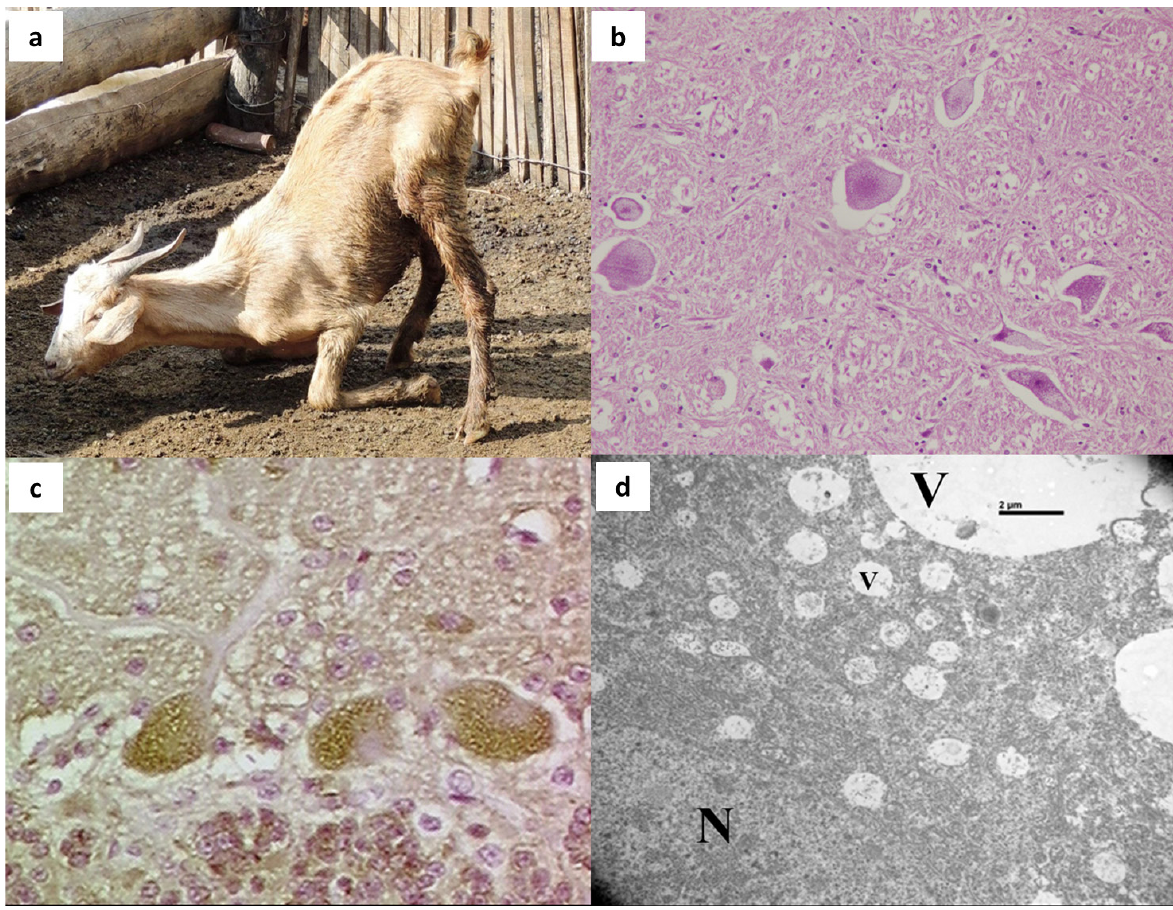
Figure 4. a. Clinical signs. Spontaneous poisoning of a goat by Sida rodrigoi . The goat shows abnormal posture due to difficulty in standing. b. Histology. Spontaneous poisoning of sheep by Astragalus garbancillo . Cerebellar basal nuclei show severe cytoplasmic vacuolation. HE, bar 25 μm. c. Lectin histochemistry. Spontaneous poisoning of a goat by Sida rodrigoi . Lectin WGA labeled the perikaryon of Purkinje cells in goats. Lectin histochemistry, bar 25 μm. d. Transmission electron microscopy (TEM). Experimental poisoning of sheep by Astragalus pehuenches . Purkinje cell showing numerous membrane-bound cytoplasmic vacuoles (V) measuring 1 to 10 μm in diameter. These vacuoles rarely contain membrane